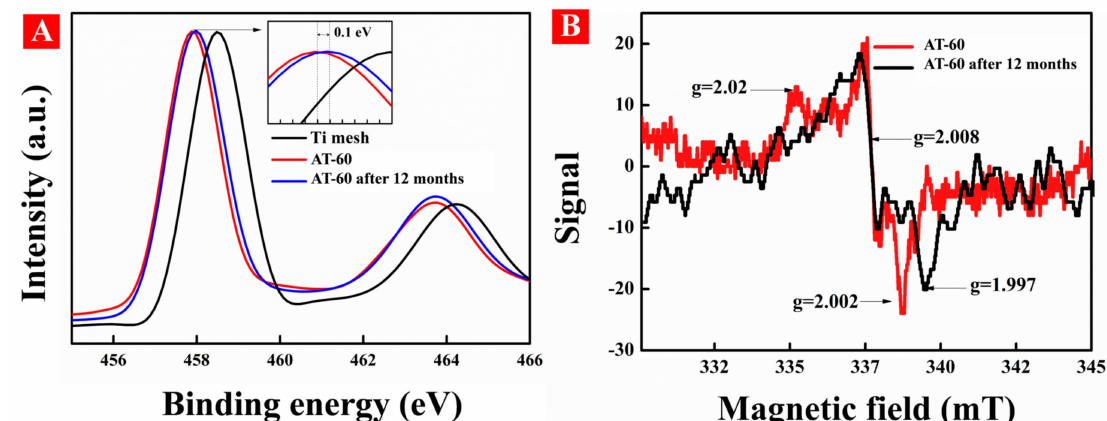
Figure 13. ( A ) X-ray photoelectron spectra (XPS) and ( B ) EPR spectra of the AT-60 and it after 12 months storages in